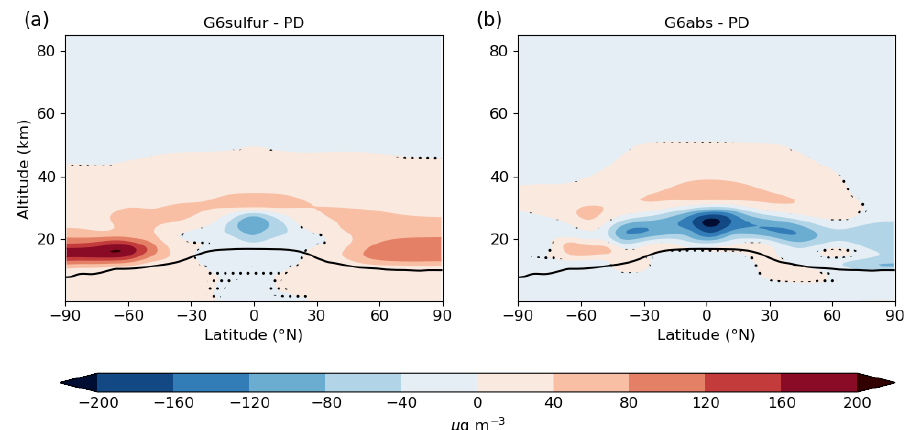
Figure 6. The perturbation to stratospheric ozone for 2081–2100 compared to PD for (a) G6sulfur and (b) G6abs. The modelled tropopause is marked by the black line. Stippling represents areas that are not significant at the 5% level using a two-tailed t -test.